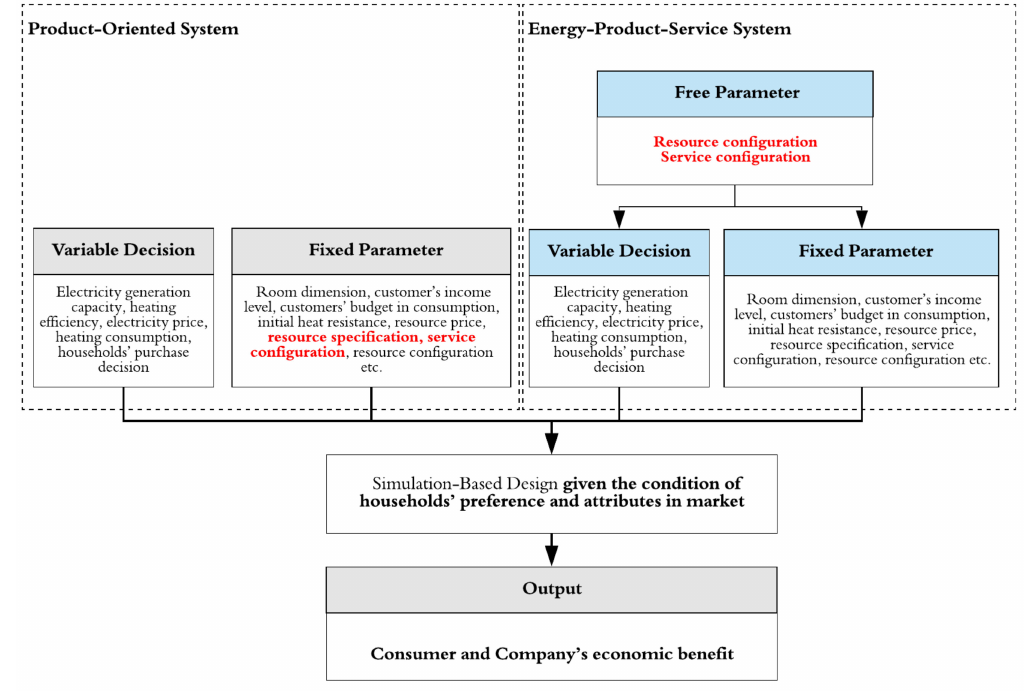
Figure 9. Simulation-Based Design to design and evaluate EPSS service performance relative to POS service